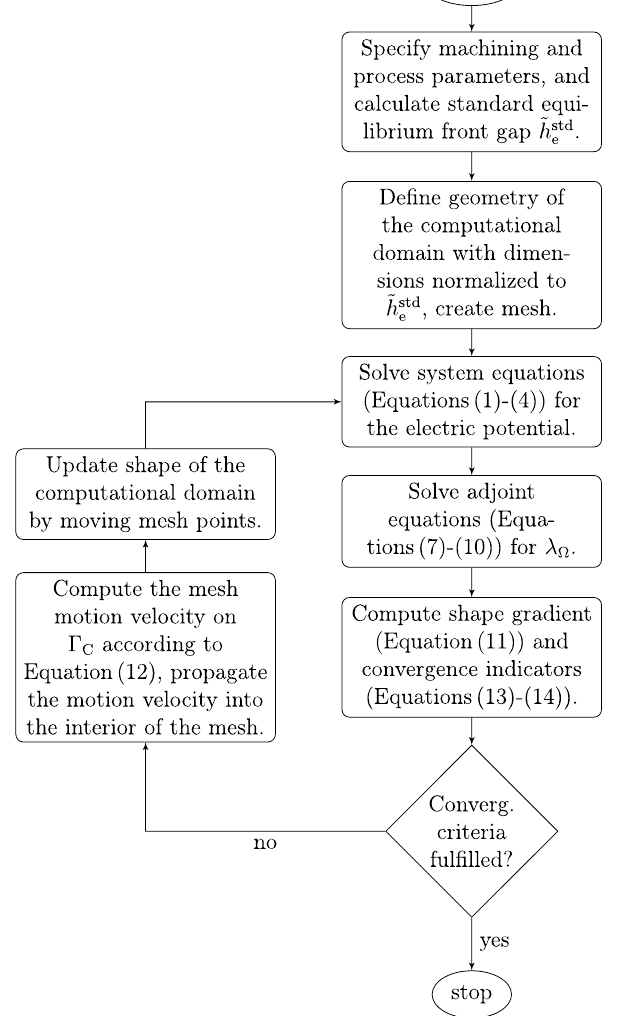
Figure 2. Flowchart of the cathode shape design algorithm based on continuous adjoint shape